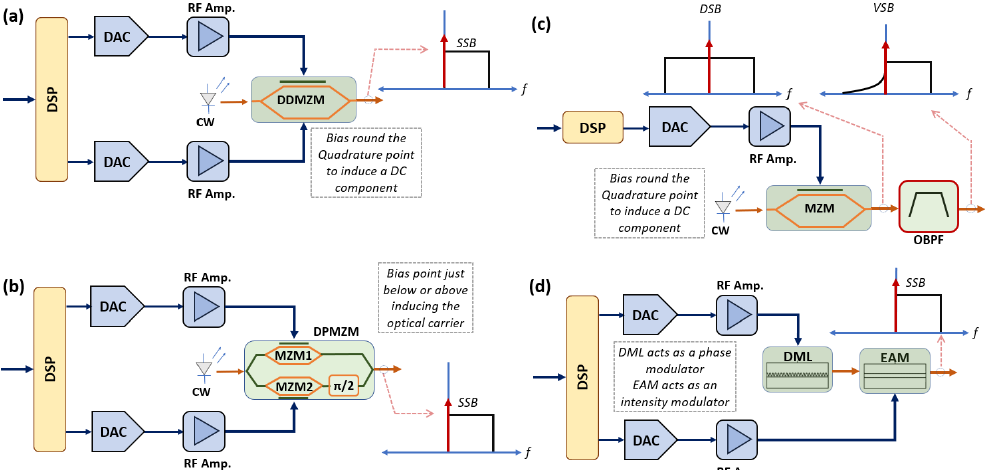
Figure 5. A representative depiction of four primary SSB signals generation techniques: ( a ) Dual drive MZM (DDMZM) biased at the quadrature point to induce a DC component, ( b ) Dual Parallel MZM (DPMZM) with virtually induced carrier, ( c ) Single drive MZM in tandem with an OBPF producing a vestigial side-band (VSB) signal, ( d ) Dual modulation of a DML integrated with an